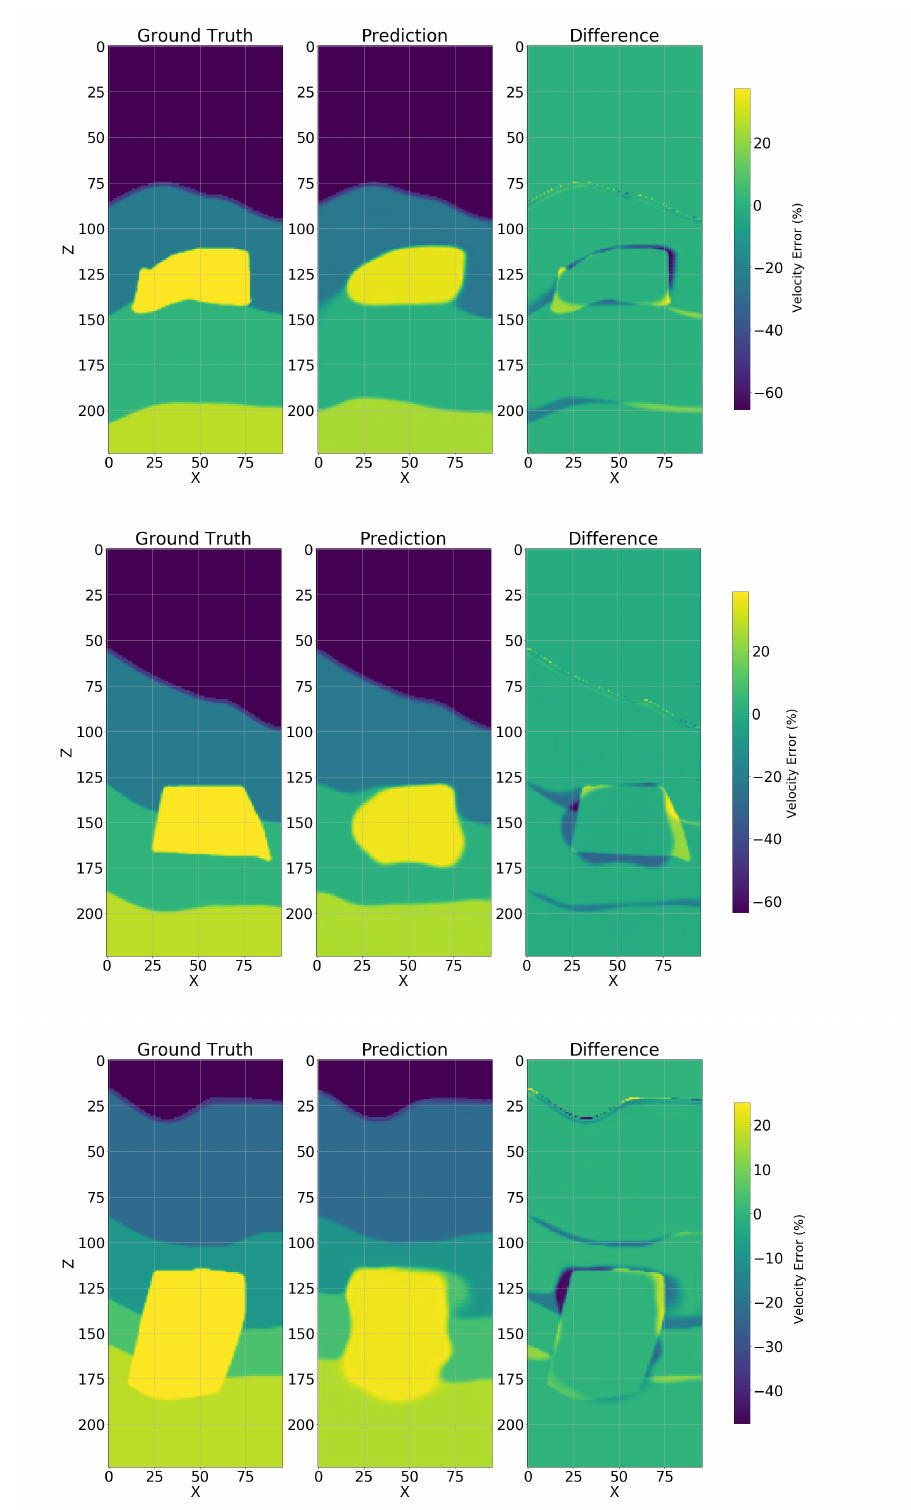
Figure 6. Three testing samples were selected and a 2D (central inline) cut is shown, a comparison between ground-truth and prediction is presented in terms of error. As expected, the greater error (right most bar, in percentage) occurs around the salt geometry and mostly over estimating the model velocity, nevertheless the background velocity is overall